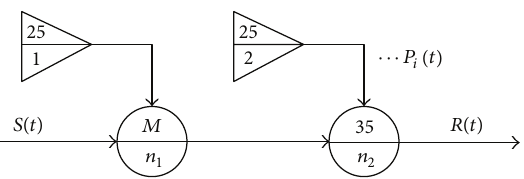
Figure 3: Assembled GO-FLOW model for repairable component.